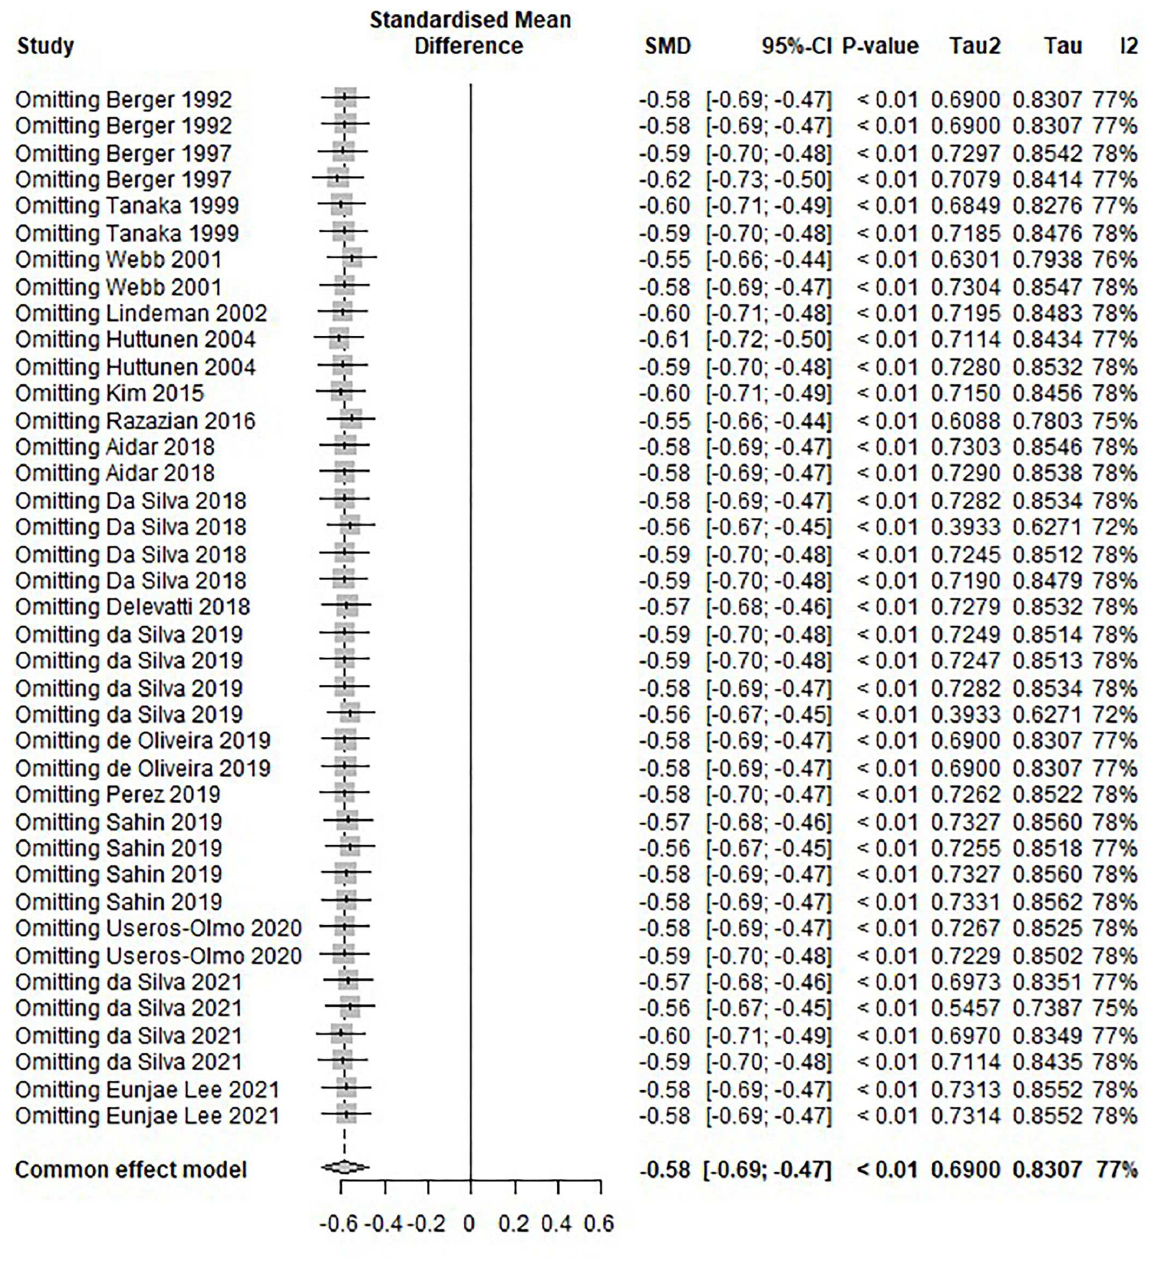
FIGURE12 Sensitivity analysis plot. A leave-one-out meta-analysis was used to test the publication bias of a single study. No studies affecting heterogeneity were found (I 2 =